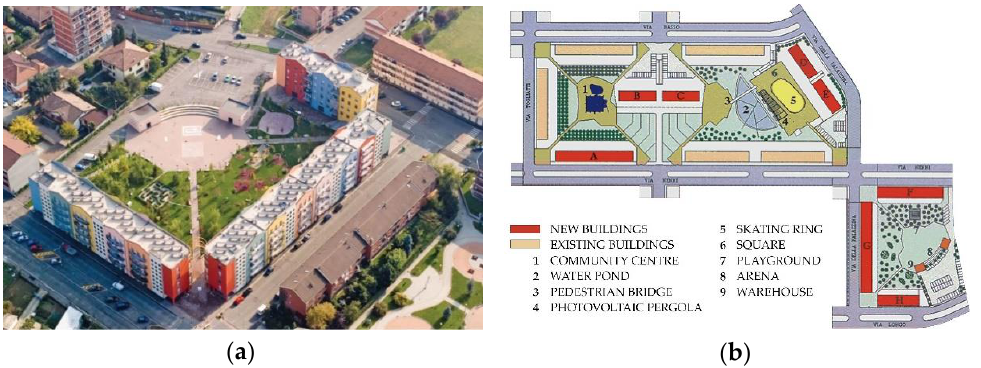
Figure 4. The ( a ) aerial view of new buildings in the eastern part of the Photovoltaic Village (source: © Municipality of Alessandria) and a site plan of the entire area indicating the position of facilities, new and existing buildings ( b ) (source: © Municipality of Alessandria).